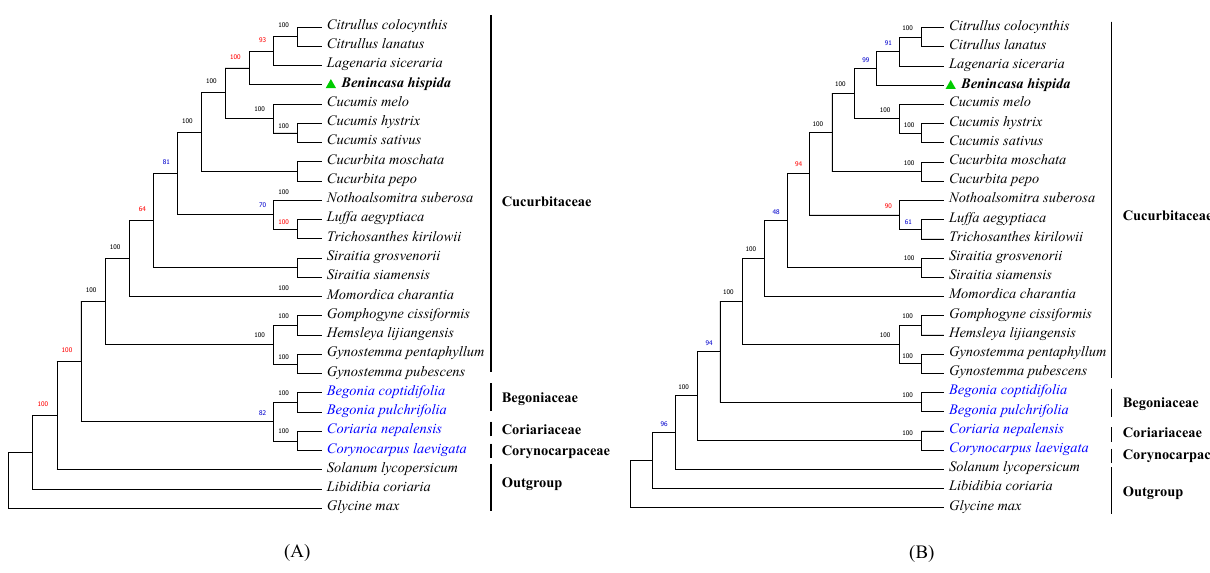
Figure 6. Maximum likelihood (ML) tree of Cucurbitales. ( A ) The phylogenetic tree constructed by complete chloroplast genome of 23 species. ( B ) The phylogenetic tree builds with 72 genes. The positions of Benincasa hispida are marked with green triangles. Numbers above branches are bootstrap values, and the bootstrap values higher or lower than those of the other tree are marked as red or blue, respectively. Glycine max set as the root in both